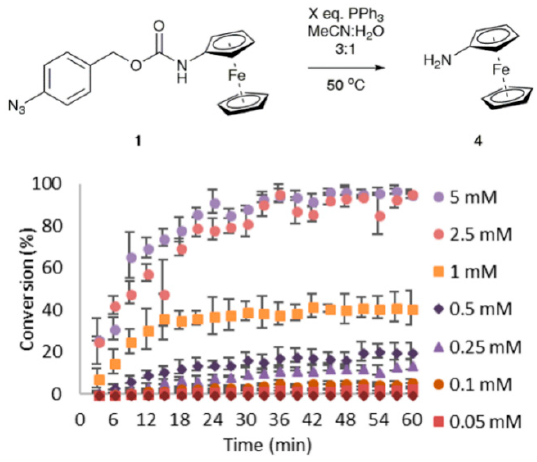
Figure 2. Conversion of probe 1 (1 mM) to aminoferrocene 4 after the addition of triphenylphosphine in MeCN:H 2 O (3:1, 1M) at 50 °C. Error bars represent the standard deviation where n = 3.